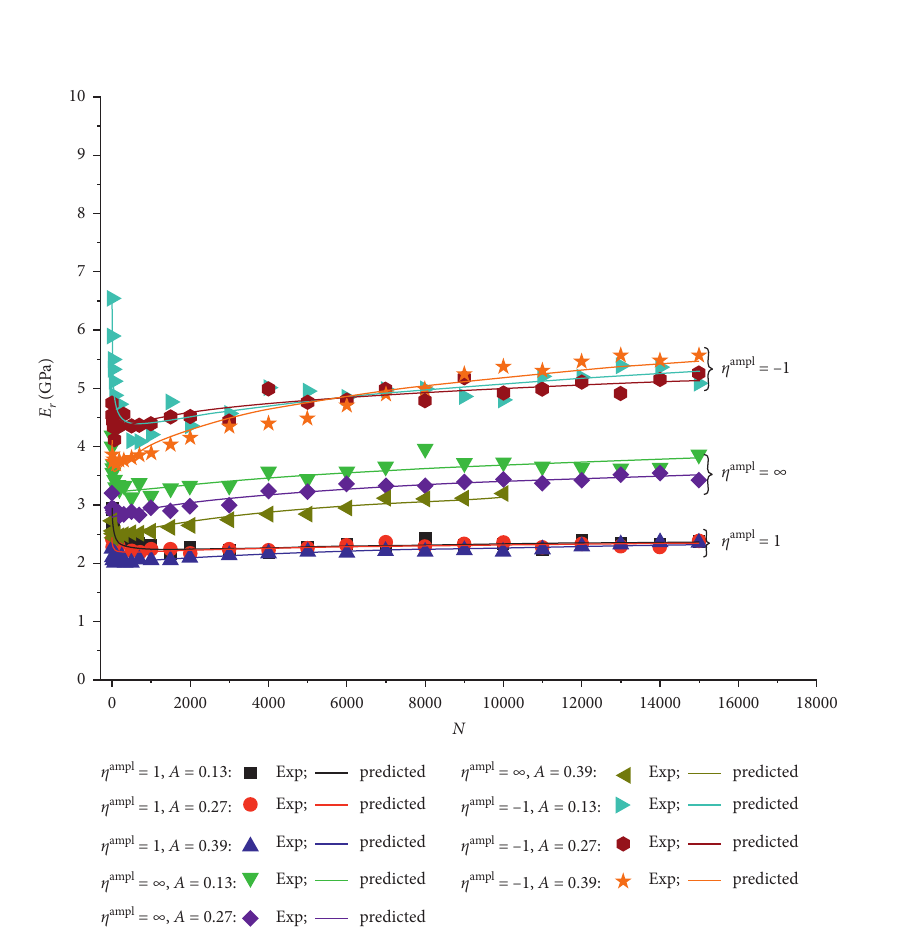
Figure 5: The relationship between resilient modulus and the number of loading cycles under different loading angles and length of dynamic stress